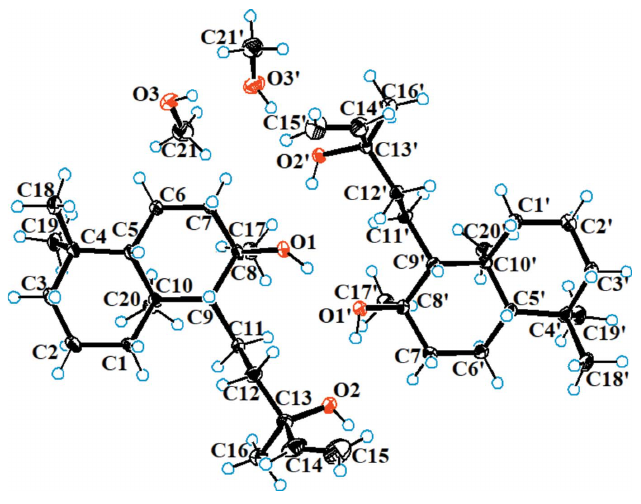
Figure 1 The molecular structure of 1 with displacement ellipsoids drawn at the 30% probability